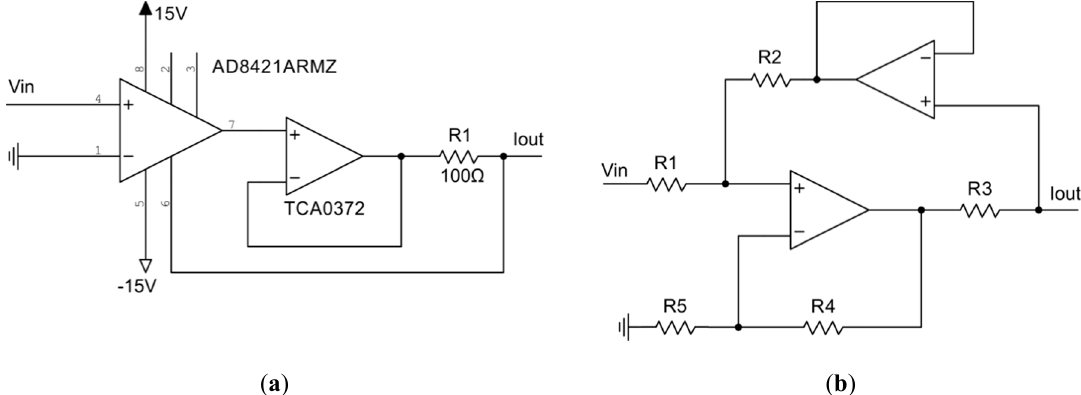
Figure 9. Voltage-controlled current sources (VCCS): ( a ) involving instrumental amplifier and operational amplifier; ( b ) involving two operational amplifiers.